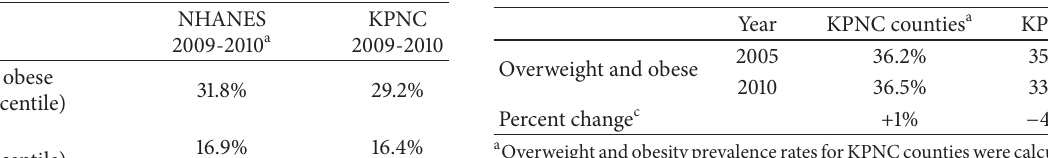
Table 4: Overweight and obesity in children aged 2–19, in KPNC and NHANES.